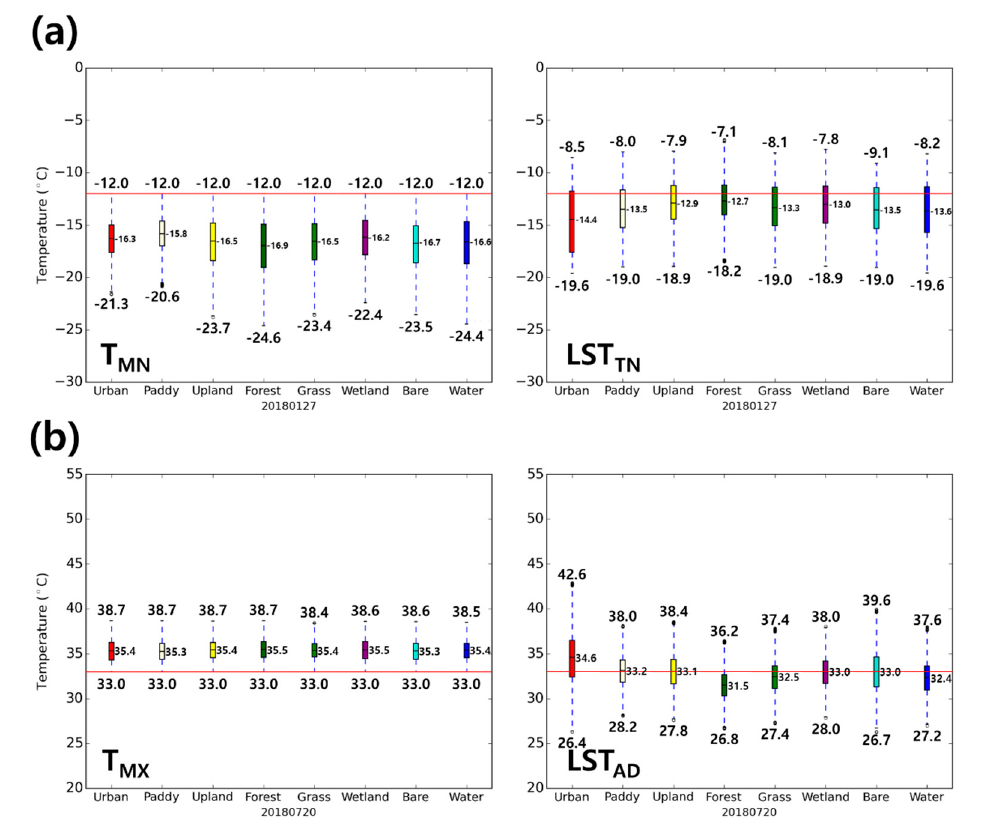
Figure 7. Boxplots of ( a ) observed T MN and LST TN for 8 land use classes (red: urban, light yellow: paddy, yellow: upland crop, dark green: forest, green: grass, purple: wetland, cyan: bare field, and dark blue: water) on January 27, 2018, and ( b ) observed T MX and LST AD on July 20, 2018. In ( a ), the red solid line on the graph is -12 ◦ C, which represents the reference temperature of the cold wave and in ( b ), the red solid line on the graph is 33 ◦ C, which represents the reference temperature of the heat wave.